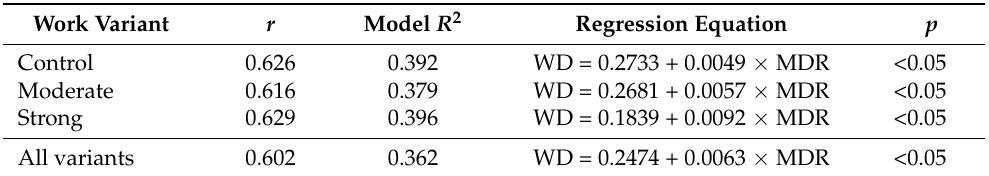
Table 6. Using regression models to predict wood density (WD) with Resistograph readings (ampli- tude) of microdrilling resistance (MDR) considering the tending forestry work